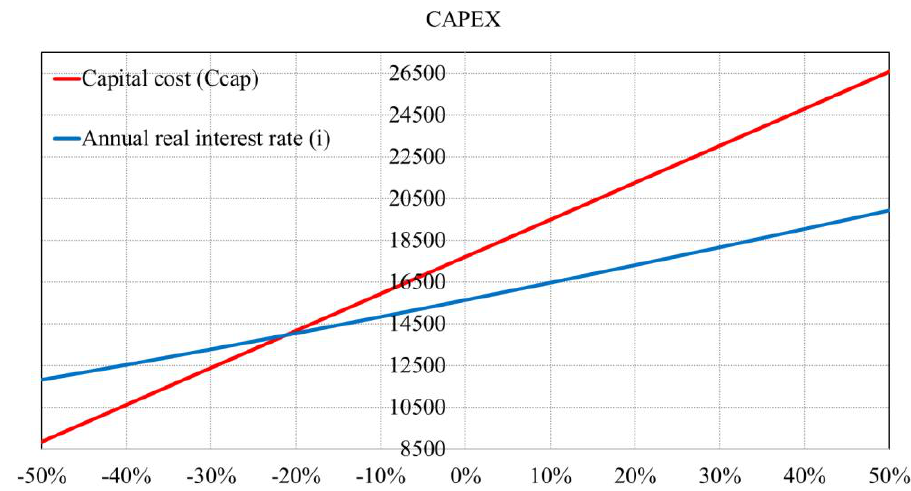
Figure 31. Sensitivity analysis on the CAPEX.